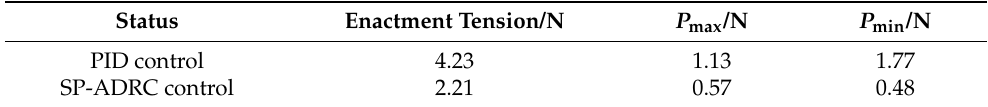
Table 1. Control performance evaluation results.